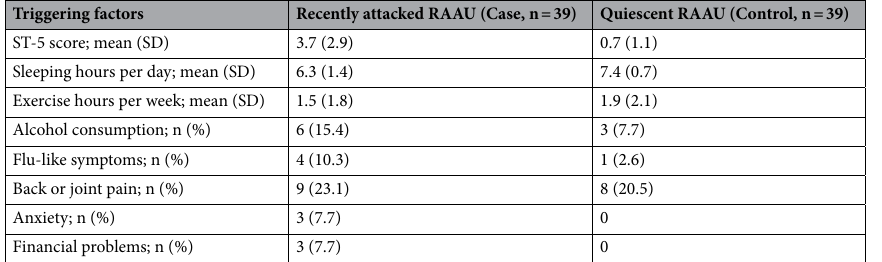
Table 2. Distribution of potential triggering factors for the occurrence of uveitis attack in patients with recurrent acute anterior uveitis (within last 4 weeks before uveitis attack or interview). RAAU recurrent acute anterior uveitis, ST-5 Srithanya Stress Test, SD standard deviation.